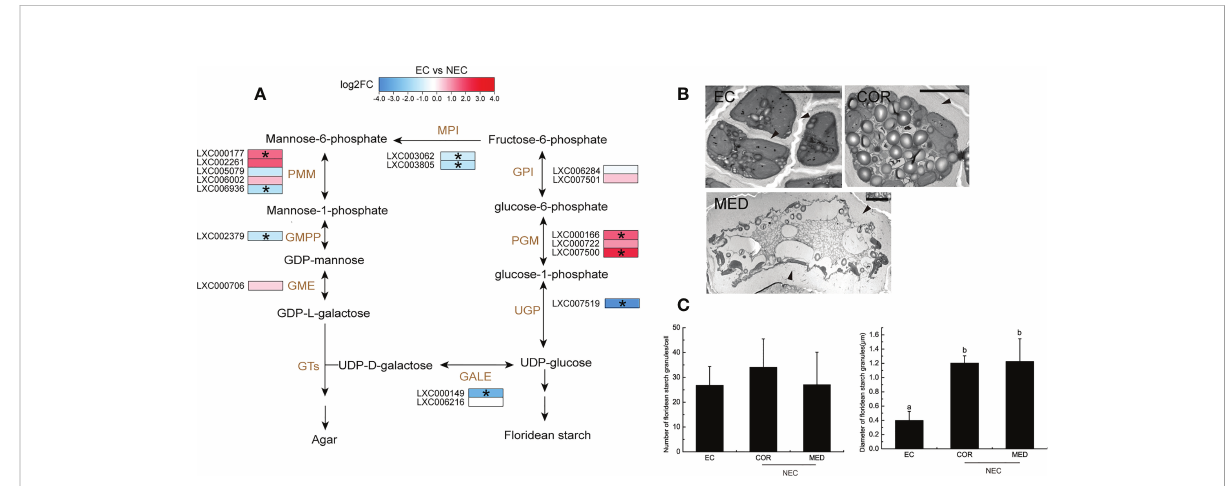
FIGURE 6 Agar and fl oridean starch metabolism of EC and NEC. (A) Heat map shows the expression level of differentially expressed genes (DEGs) in the metabolism pathway of agar and fl oridean starch in EC and NEC. Metabolic pathway was as described by Lee et al. (2017) and Yu et al. (2021).